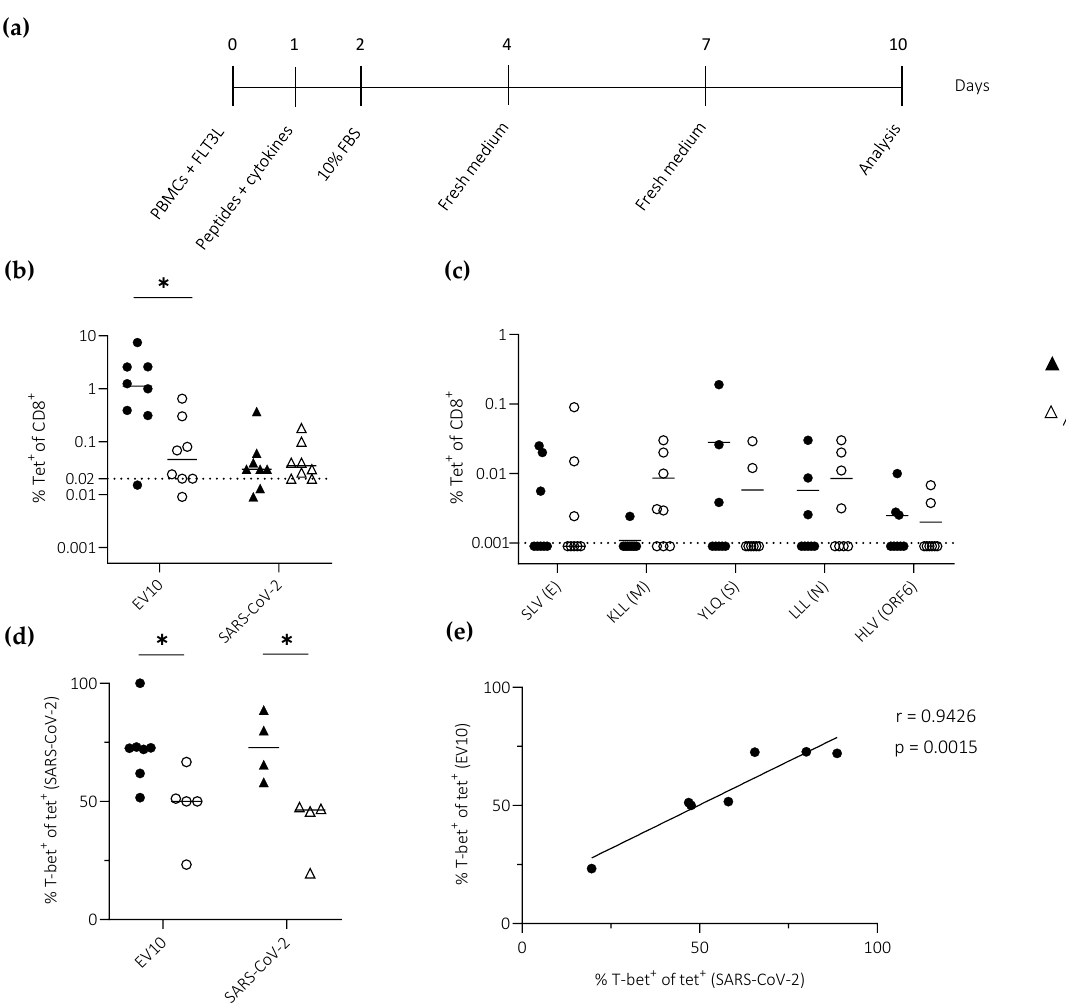
Figure 3. T-bet expression among primed CD8 + T cells specific for EV10 or SARS-CoV-2. ( a ) Schematic representation of the in vitro priming approach. ( b , c ) Epitope-specific CD8 + T cell frequencies quanti- fied using the EV10 tetramer or SARS-CoV-2 tetramers in a single pool (n = 5) ( b ) or individually ( c ). Dotted lines indicate the limit of detection. ( d ) T-bet expression frequencies among tetramer-labeled CD8 + T cells quantified as in ( b ). ( e ) Pearson correlation showing T-bet expression frequencies among EV10-specific CD8 + T cells versus T-bet expression frequencies among SARS-CoV-2-specific CD8 + T cells. ( b – d ) Horizontal lines represent median values. * p < 0.05 (Mann–Whitney U